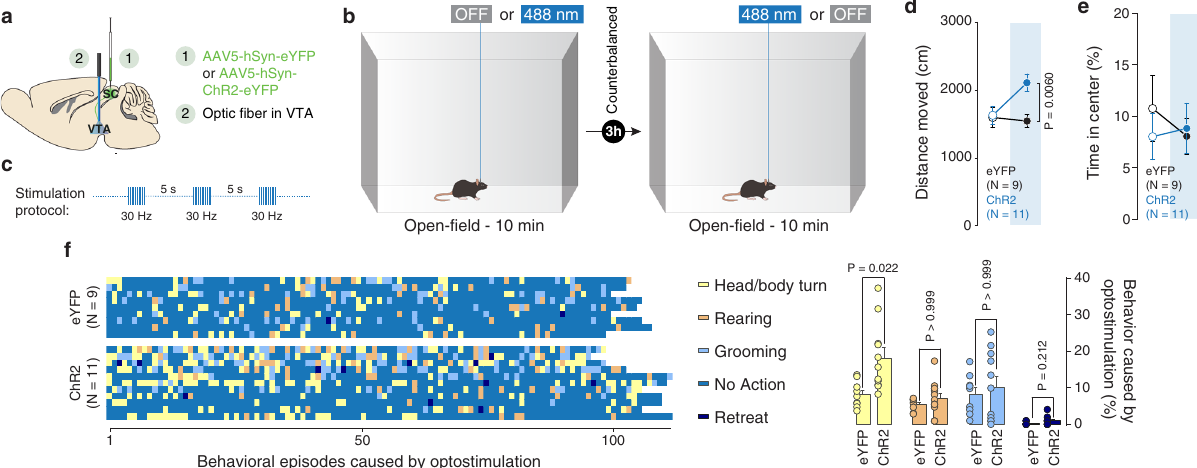
Fig. 6 SC-VTA optostimulation increases exploratory behavior. a Schema of injections sites in SC with AAV5-hSyn-eYFP or AAV5-hSyn-ChR2-eYFP, and optic fi ber implantation above the VTA. b Schema of the open- fi eld arena. The mice are free to explore the apparatus for 10 min in both stimulations ’ conditions. c Stimulation protocols: 8 pulses of 488 nm light (30 Hz) were separated by 5 s in the light ON condition. d Distance moved in the open- fi eld arena for eYFP and ChR2 mice under light and no-light stimulation. RM two-way ANOVA (Light main effect: F (1,18) = 4.0046, P = 0.0607; Virus main effect: F (1,18) = 4.8210, P = 0.0415; Light × Virus interaction: F (1,18) = 4.8217, P = 0.0415) followed by Bonferroni-Holm post-hoc test correction. e Time passed in the center of the open- fi eld arena for eYFP and ChR2 mice under light and no-light stimulation. RM two-way ANOVA (Light main effect: F (1,18) = 0.1628, P = 0.6913; Virus main effect: F (1,18) = 0.145, P = 0.7078; Light × Virus interaction: F (1,18) = 0.546, P = 0.4695). f Right panel: identi fi cation and report of the behavioral episodes caused by a burst of optostimulation. Left panel: quanti fi cation of the behavioral episodes caused by a burst of optostimulation. Two-way ANOVA (Behavior main effect: F (2.004, 36.08) = 20.47, P < 0.0001; Group main effect: F (1, 18) = 5.370, P = 0.0325; Behavior× Group Interaction: F (3, 54) = 3.364, P = 0.0251) followed by Bonferroni ’ s multiple comparisons post-hoc test. N indicates the number of mice. # indicates signi fi cantly different interaction. All the data are shown as the mean ± s.e.m. as error bars. Source data are provided as a Source Data fi